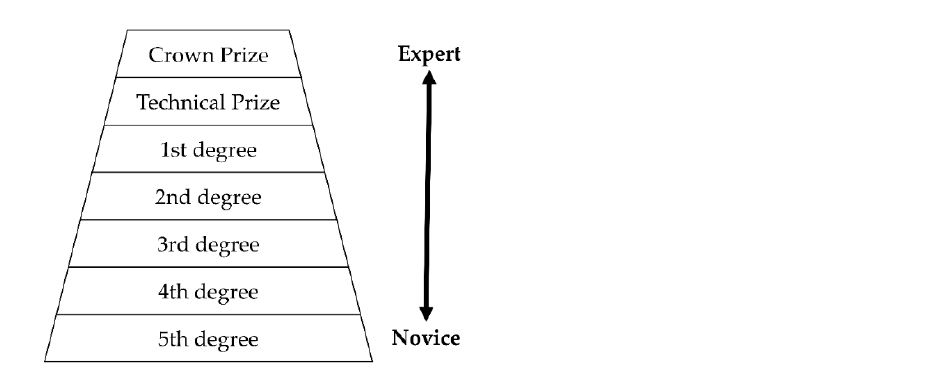
Figure 1. Ski Association of Japan technical certification ranks. Assessment is carried out by several judges who score the ability to ski in response to the situation and conditions, organization of the turn movements (positioning and edging), the ability to adapt to piste conditions (speed and rotation arc adjustment), and movement (balance, rhythm, and timing).